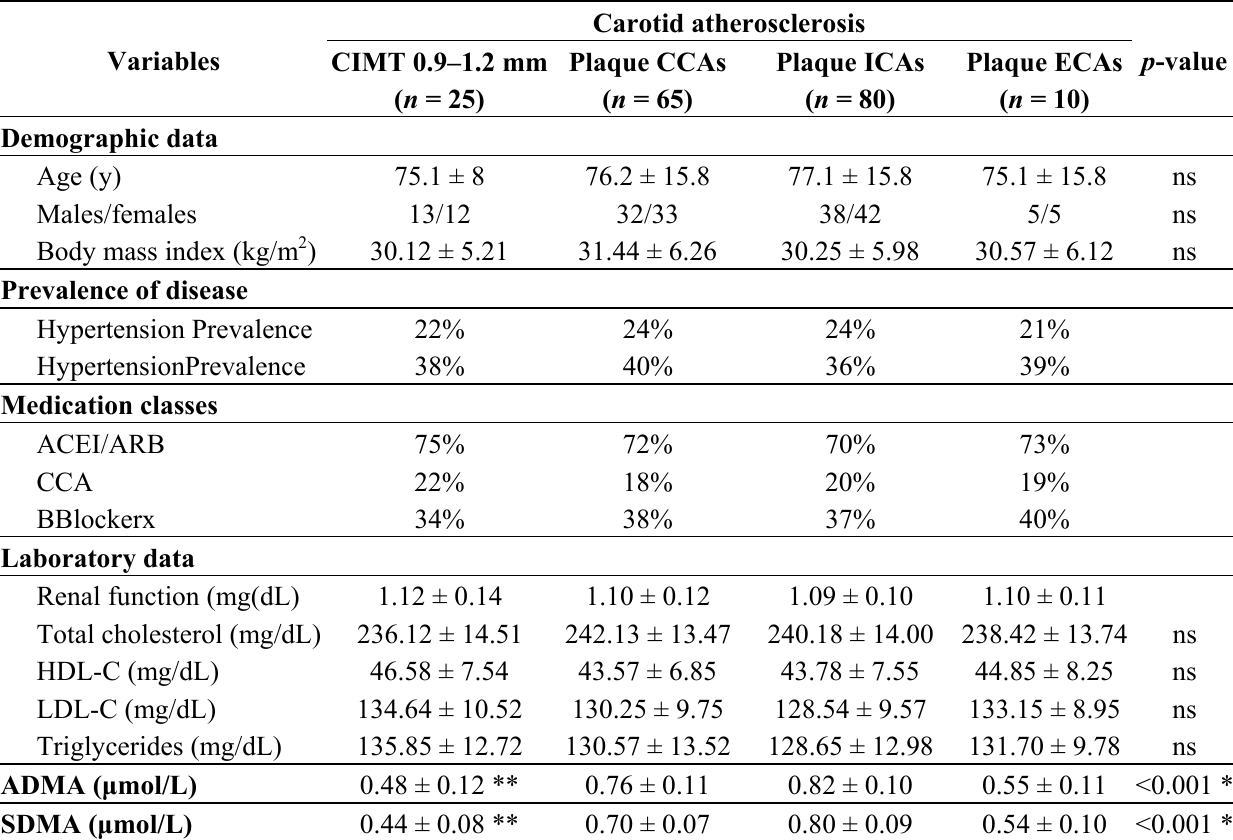
Table 1. Characteristics of the study population and laboratory